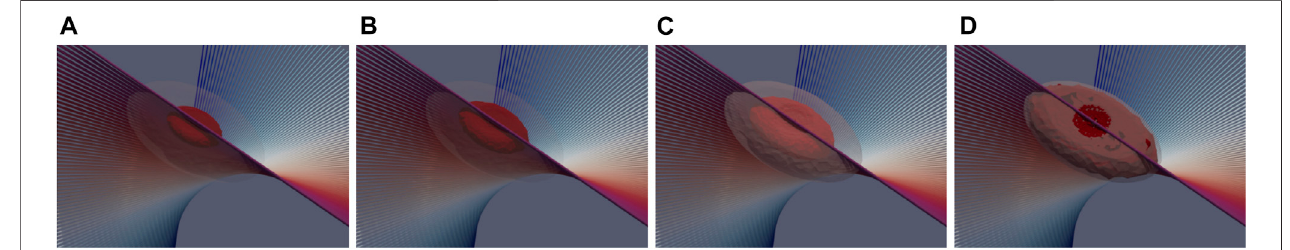
FIGURE 10 | 3D views of the numerical lesion resulting from the three-state cell model for different threshold levels N thr : (A) 0.8, (B) 0.9, (C) 0.95, and (D) 0.99. A shaded view of the 50 ° C thermal isocontour method is provided for comparison.